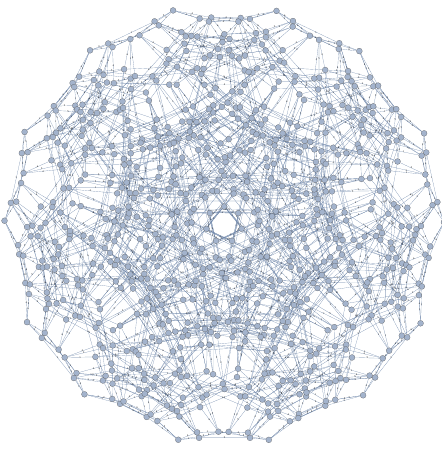
Figure5: Theexchangegraphfor E 6 . Figure 4. The cluster polytope of Gr(4 ; 7) ’ E